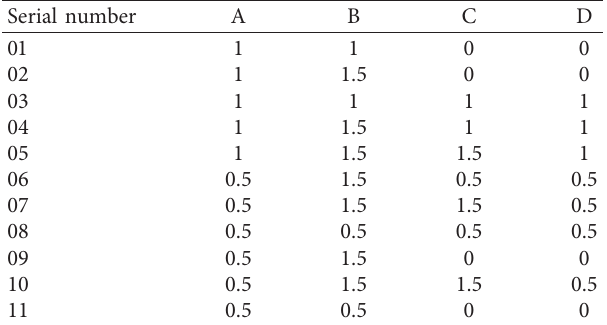
Table 2: Initial preset cracks of two-hole specimen with constant amplitude.